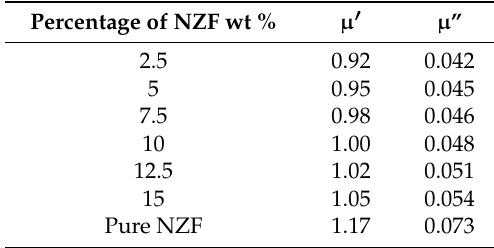
Table 4. Variations in µ (cid:48) and µ ” values at 10